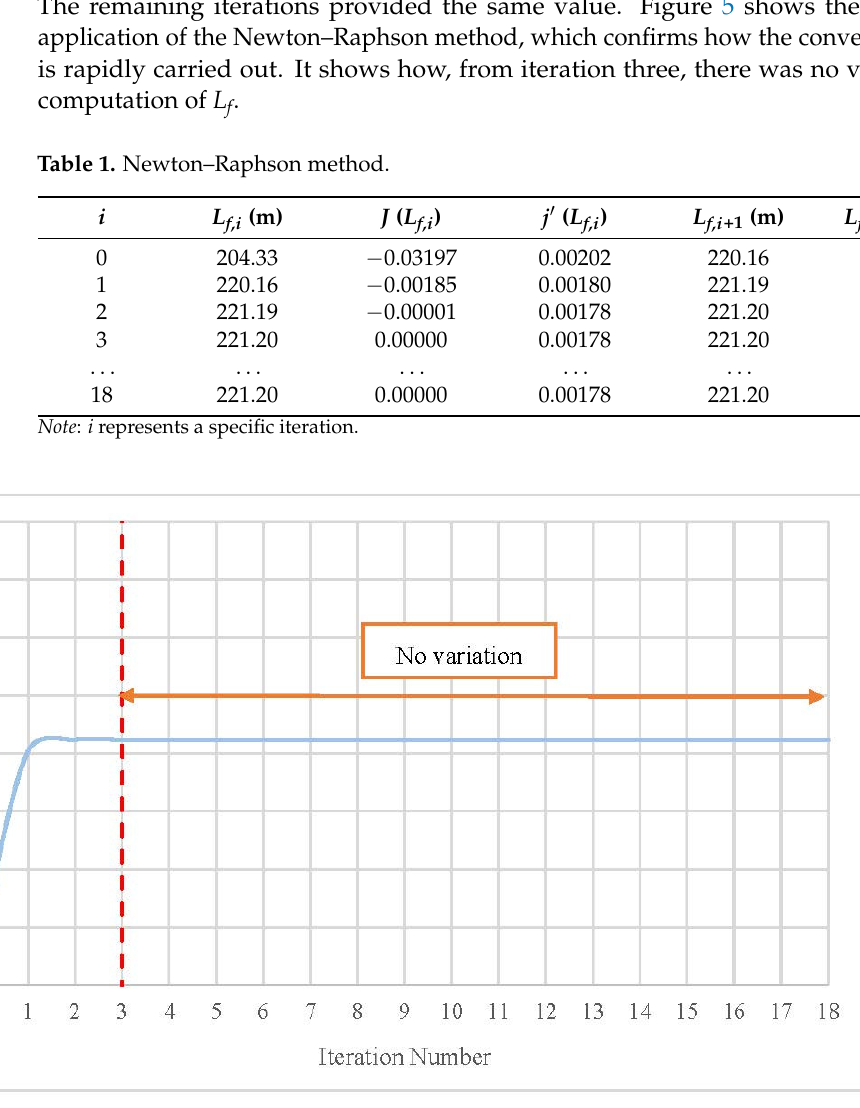
Figure 4. Length versus water velocity for the case study .